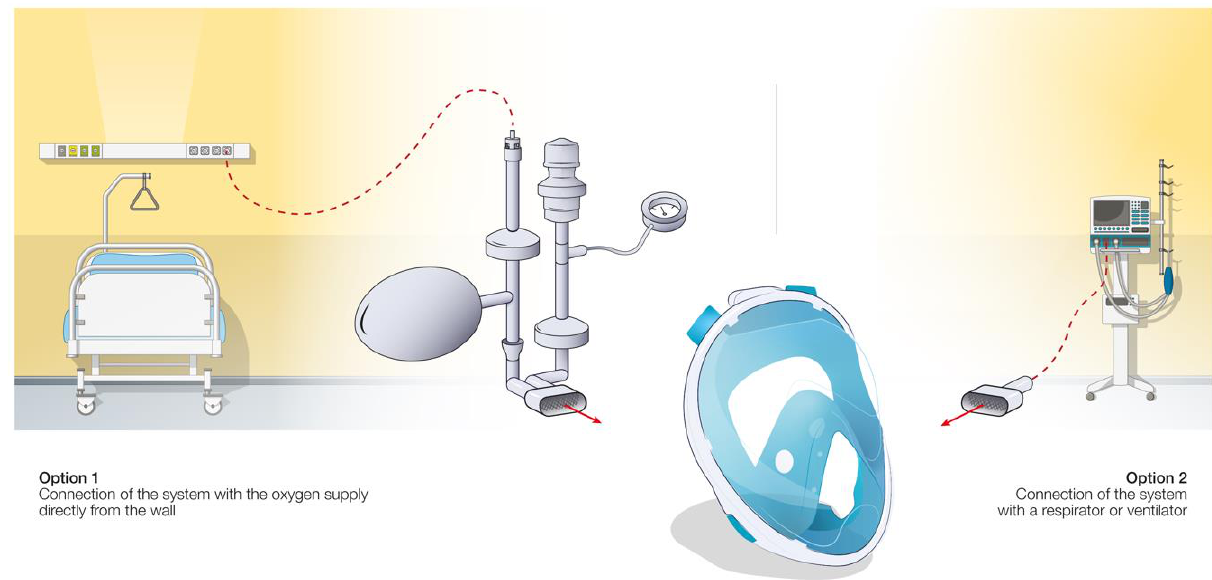
Figure 3. Different configurations of snorkeling mask usage and developed connectors as non-invasive ventilation devices.